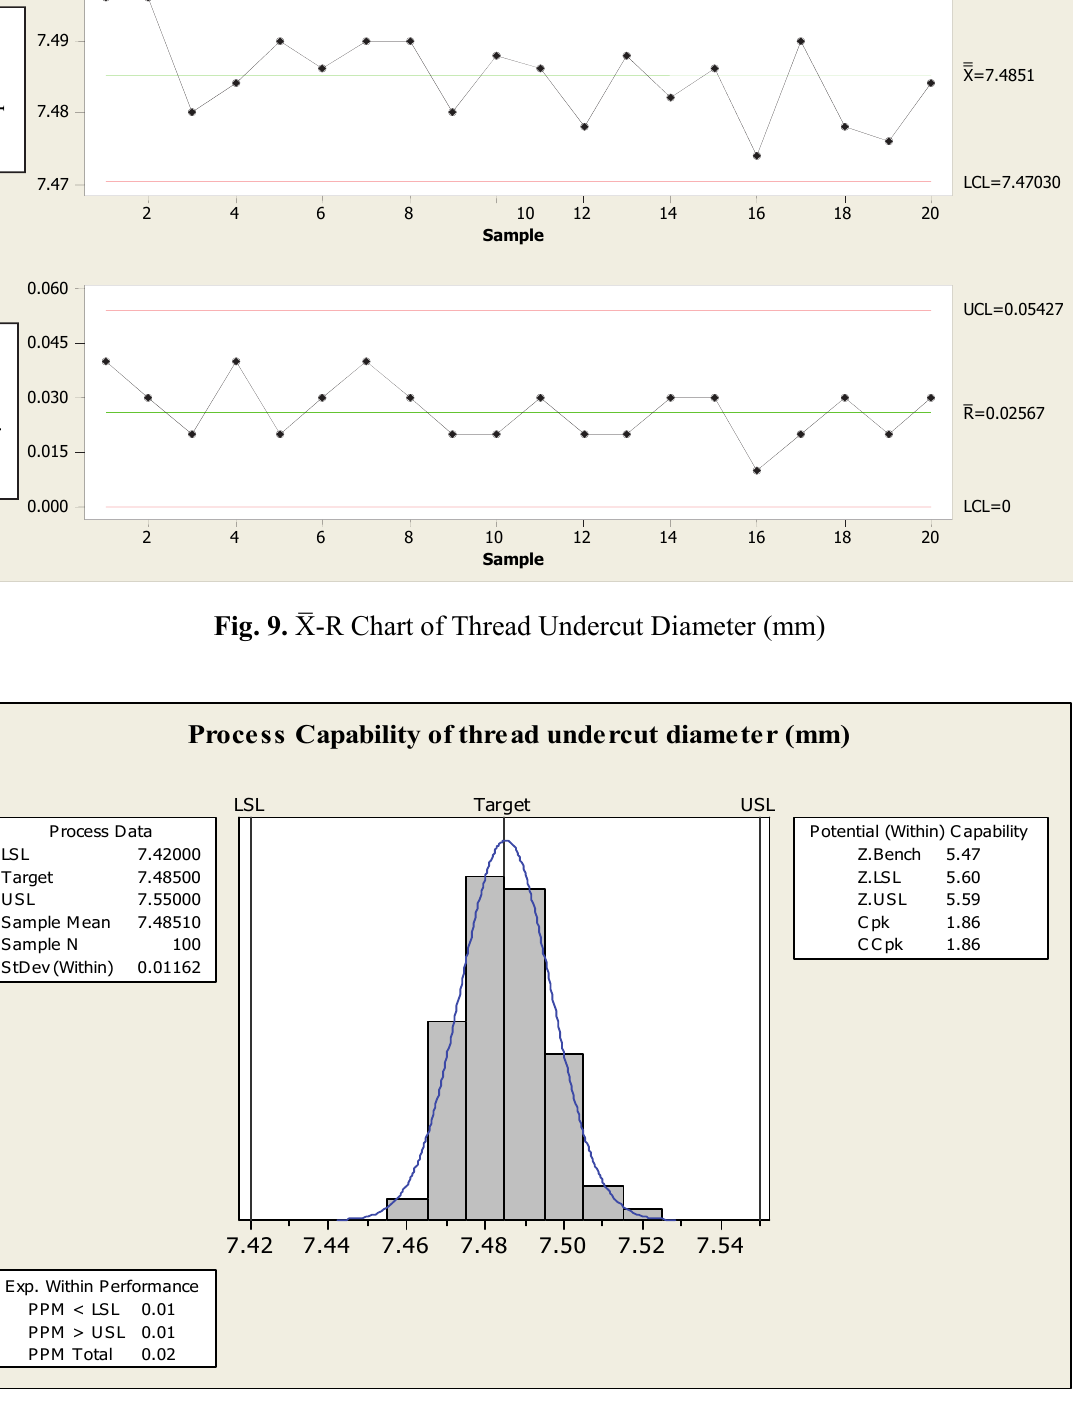
Fig. 10. Process capability analysis of thread undercut diameter after